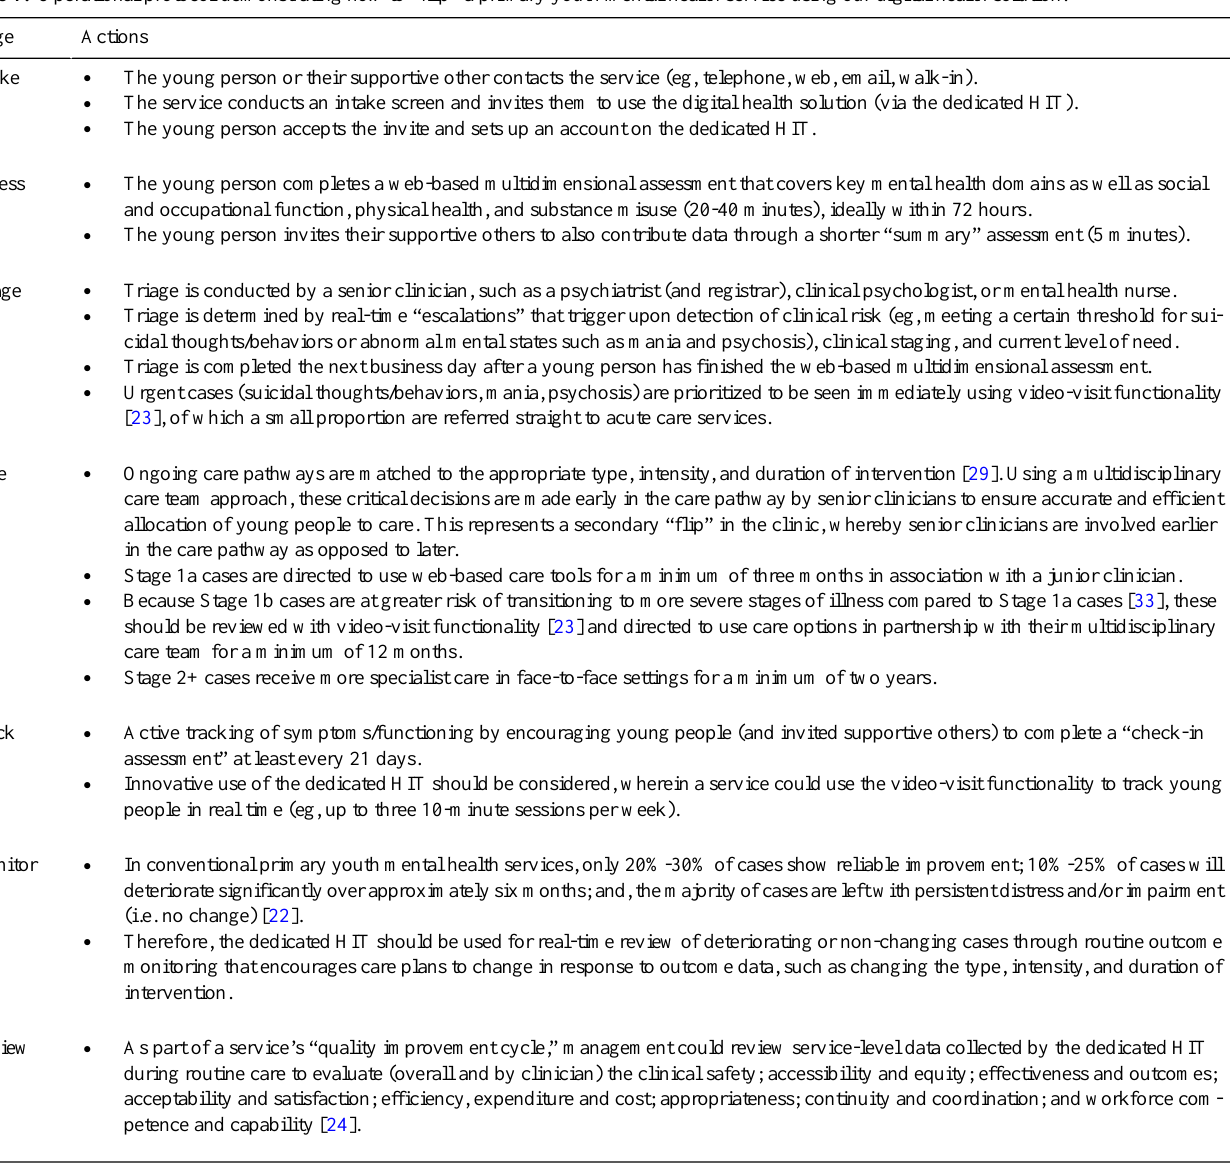
Table 1. Operational protocol demonstrating how to “flip” a primary youth mental health service using our digital health